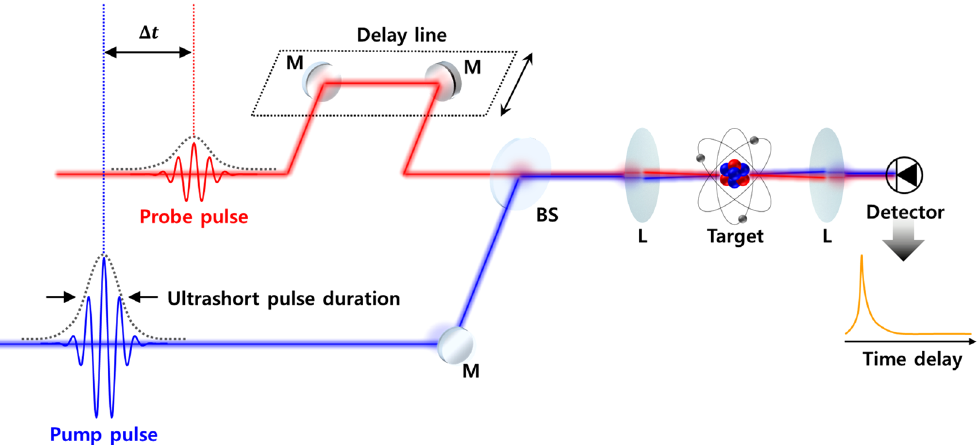
Figure 4: Typical experimental apparatus of an ultrafast pump-probe measurement. The pump and probe pulses, with ultrashort pulse duration, excite the target sample with a time delay. The time-resolved spectrum is obtained from an optical detector by scanning the delay line, which allows changingthetime delaybetweenthe pumpandthe probe pulses.The pulse duration of the probepulse limits thetemporal resolution of the spectroscopy. M, mirror; BS, beam splitter; L,